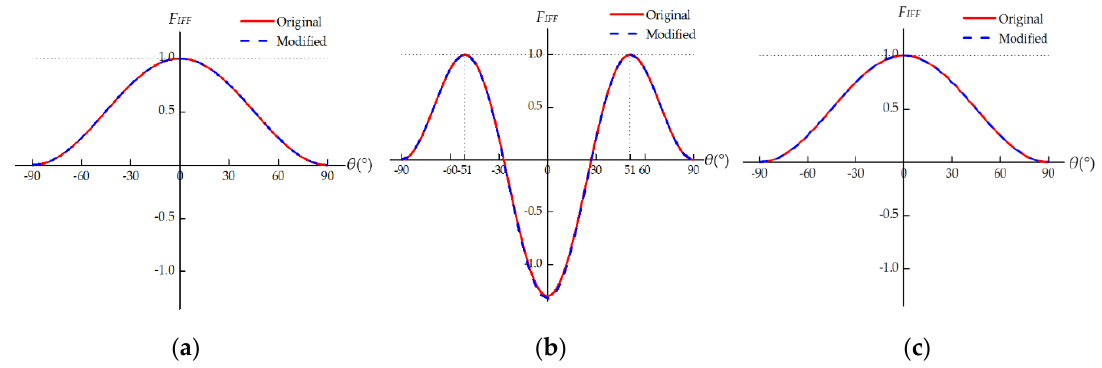
Figure 5. F IFF – θ relation under simple stress states for the ply in a unidirectional laminate. ( a ) σ 2 = Y T ; ( b ) σ 2 = − Y C ; ( c ) τ 21 = S L .